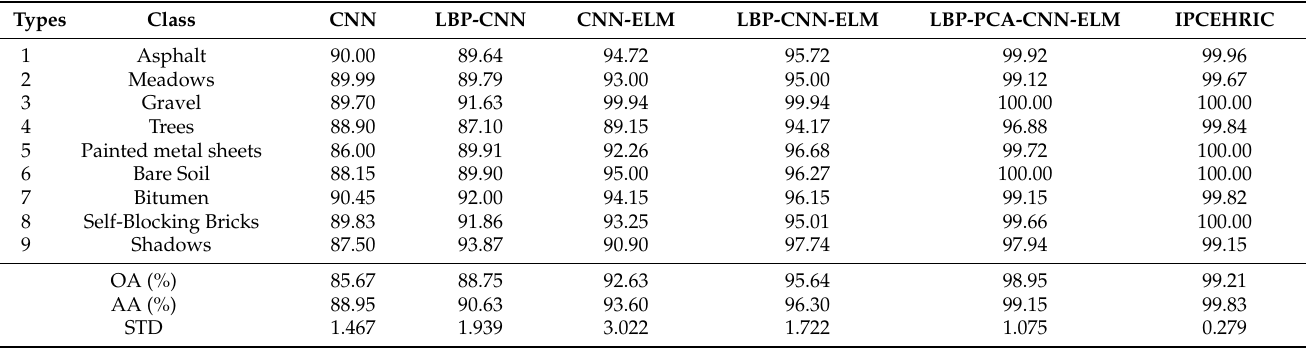
Table 3. The experiment results of the Pavia University data